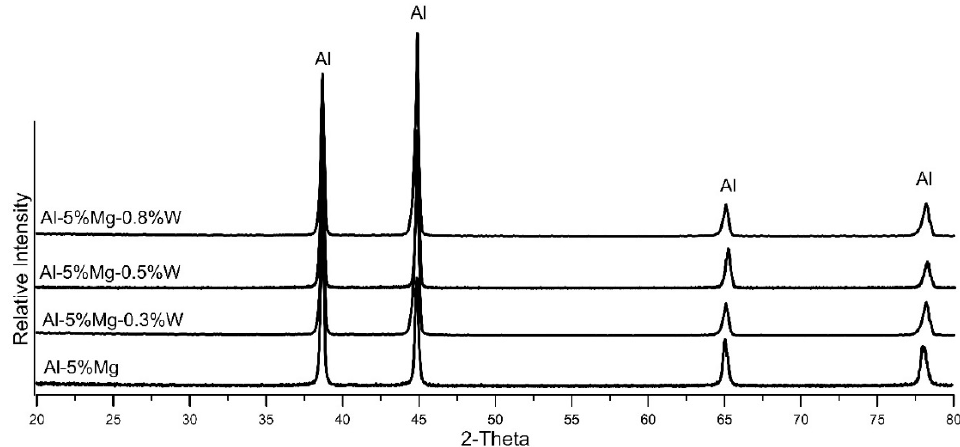
Figure 3. Results of XRD analysis of Al-5Mg alloys.